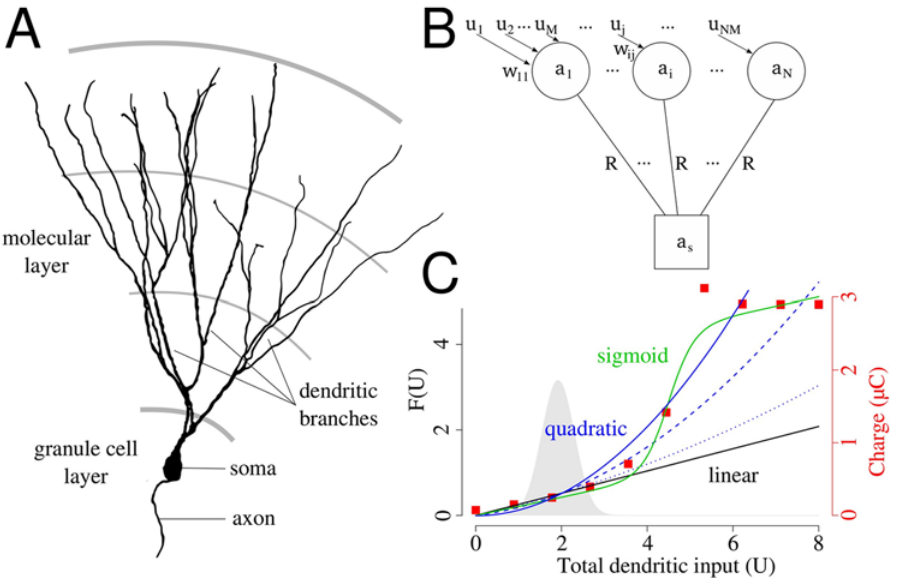
Figure 1. The structure of the model. (A) Anatomical reconstruction of the dendritic tree of a mature granule cell from mice. The dendritic tree is dominated by the long parallel dendritic branches in the outer two third of the molecular layer. Note the lack of basal dendrites and the apical trunk compared to a pyramidal neuron. Image courtesy of Dr. Josef Bischofberger. (B) Model for the somato-dendritic interactions in dentate granule cells. Distal dendritic compartments are represented by circles, and the soma by a square. Further details are in the text. (C) The different dendritic integration functions used in this study. Black: linear, blue: quadratic, green: sigmoid function. Red, square symbols indicate the nonlinearity of dendritic integration in a conductance based model of hippocampal granule cell (see Text S1). Dashed and dotted lines show different degrees of nonlinearity. The distribution of the total dendritic input with uniform synapses is shown in the background.